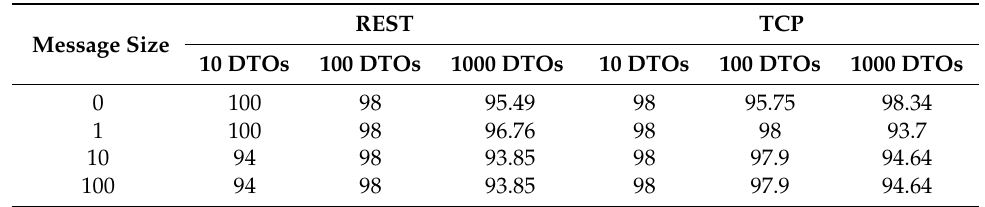
Table 1. Percentage of success on communications (Reliability) for the REST scheme experiments for each bulck of Data Transfer Objects (DTOs).